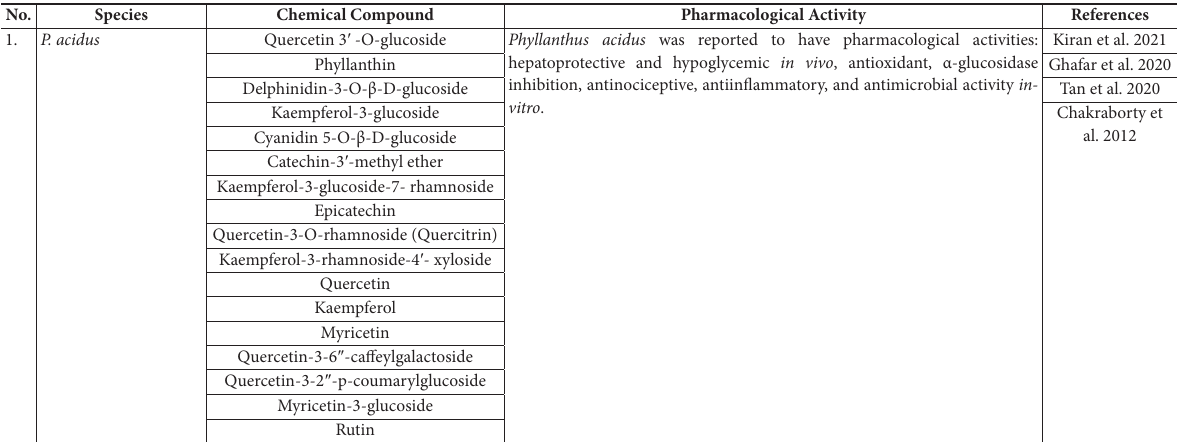
Table 1. Chemical compounds are found in the genus Phyllanthus . No.